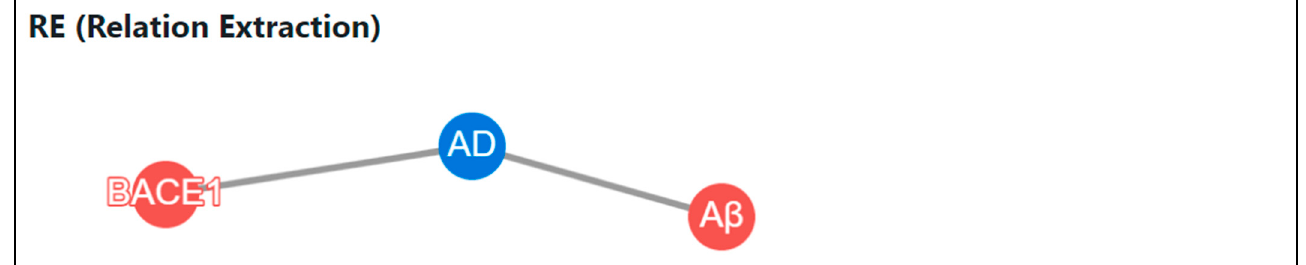
Figure 10. RE result screen on web page after PMID input.